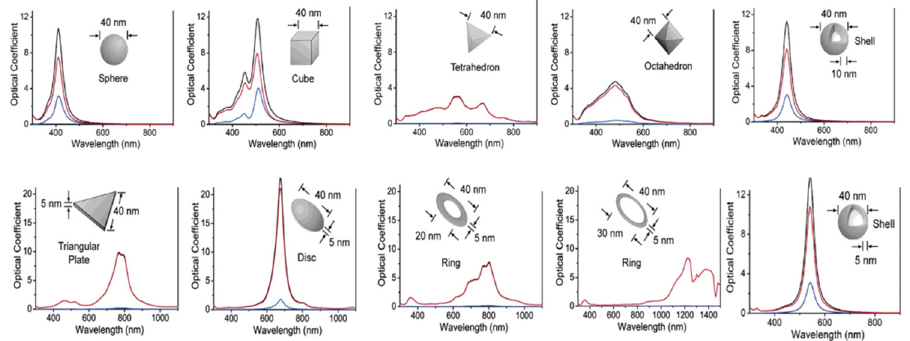
Figure 3. Effects of nanoparticles shape on the absorbance spectrum. Reprinted with permission from [52], copyright 2006, American Chemical Society.